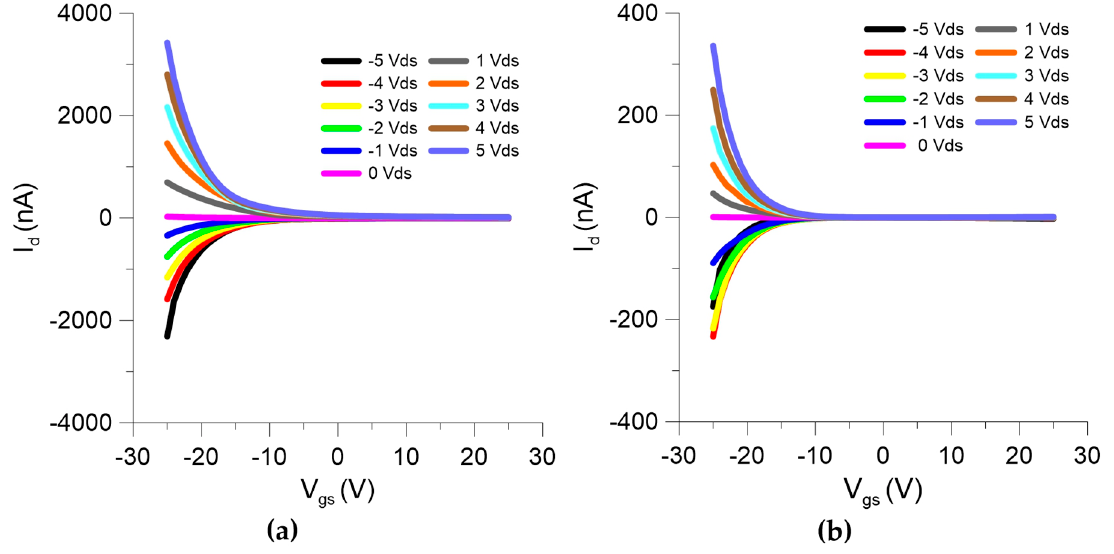
Figure 6. The up-sweep I d -V gs curves for medium density 5 µm nanonet channel FETs measured in ( a ) March and ( b ) September